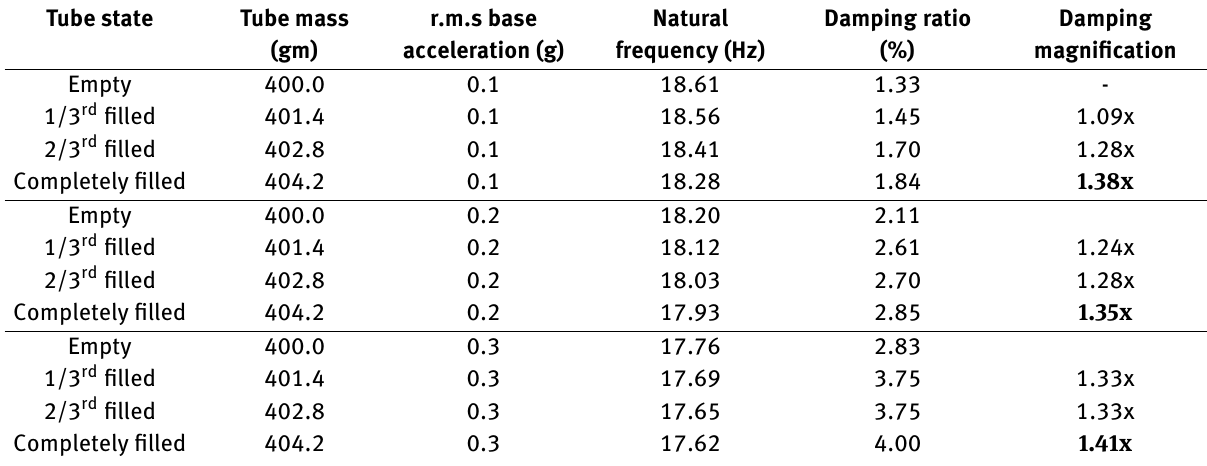
Table 1: Damping ratio of CFRP empty and foam-filled tubes (with 18 mm foam balls)